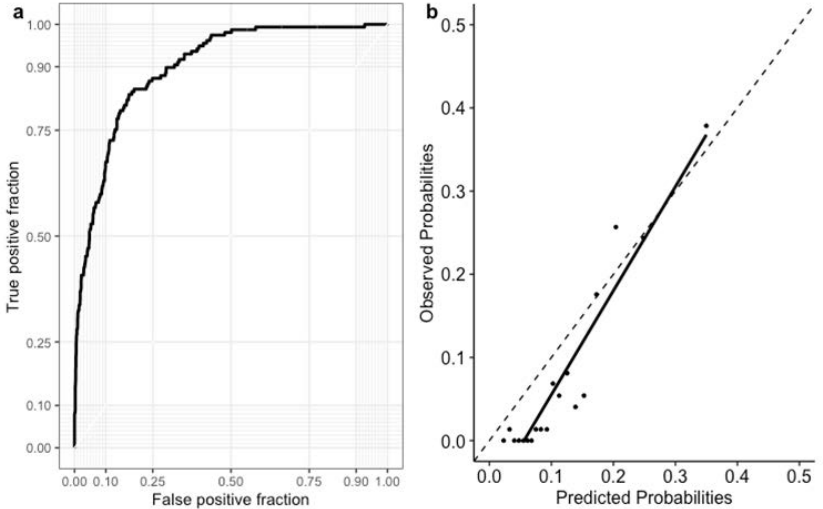
Figure 1. Area under the curve of the best performing model for predicting all-cause mortality among patients with angina ( a ). The closer to the dotted line indicates the better prediction in the calibration plot of the best performing model ( b ).